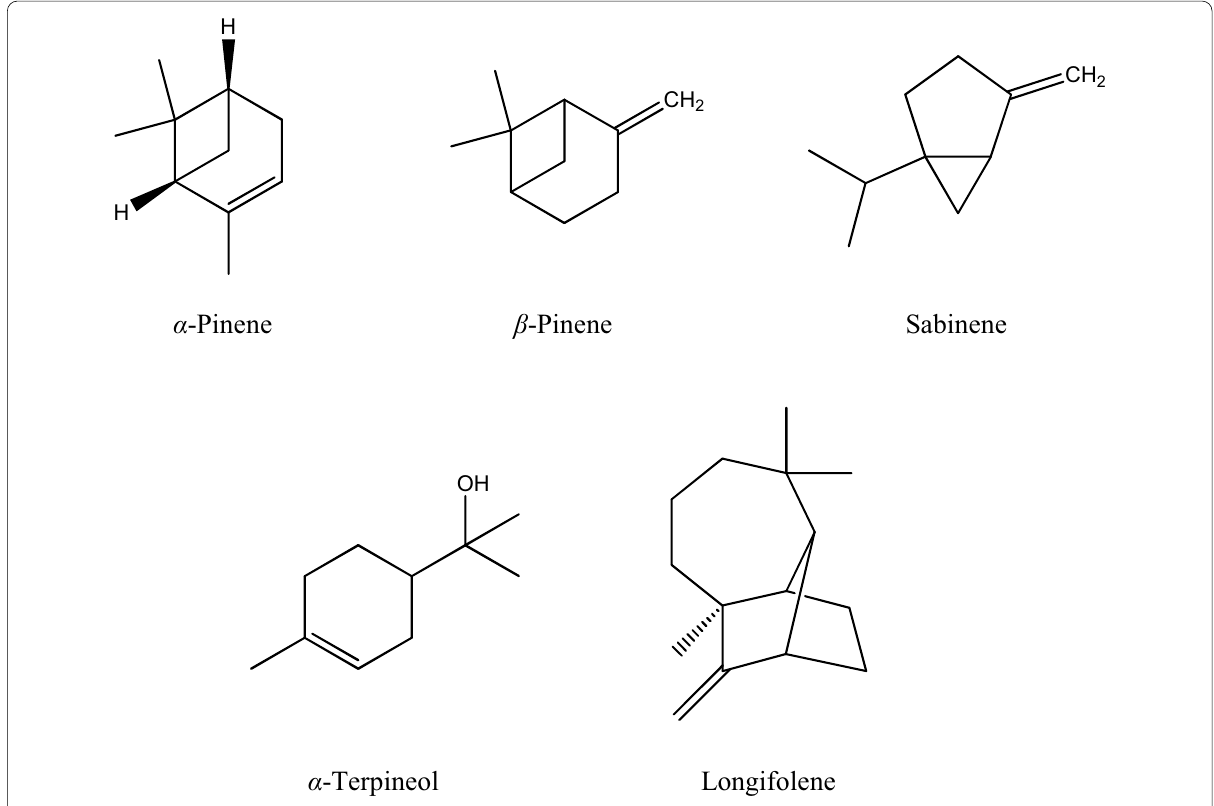
Fig. 2 Chemical structures of the main components in the five fraction oils (A–E)